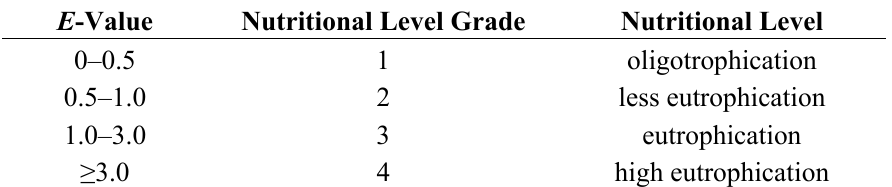
Table 3. Grade of nutritional level